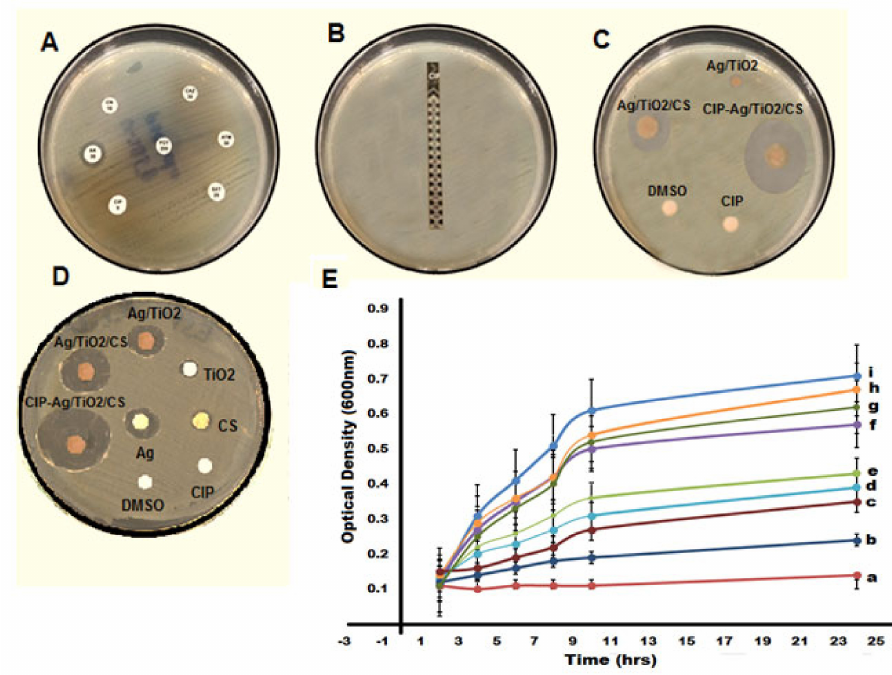
Figure 5. ( A ) Showing resistance pattern of E. coli as MDR pathogens, ( B ) displaying the highest minimum inhibitory concentration (MIC) value of ciprofloxacin with no zone by E-strip against E. coli, ( C ) zone of inhibition exhibited by synthetic and prepared antimicrobial agents, ( D ) zones of inhibition (ZIs) shown by synthesized nanoformulations at respective MICs, ( E ) kinetics of growth curves for MDR E. coli at 0.0512 µ g/mL (MIC of nanohybrid), ( a ) NC (Negative control, pure NB), ( b ) CIP-Ag/TiO 2 /CS nanohybrid, ( c ) unloaded Ag/TiO 2 /CS, ( d ) Ag/TiO 2 , ( e ) AgNPs, ( f ) TiO 2 NPs, ( g ) CS, ( h ) CIP, ( i ) PC (positive control E. coli in